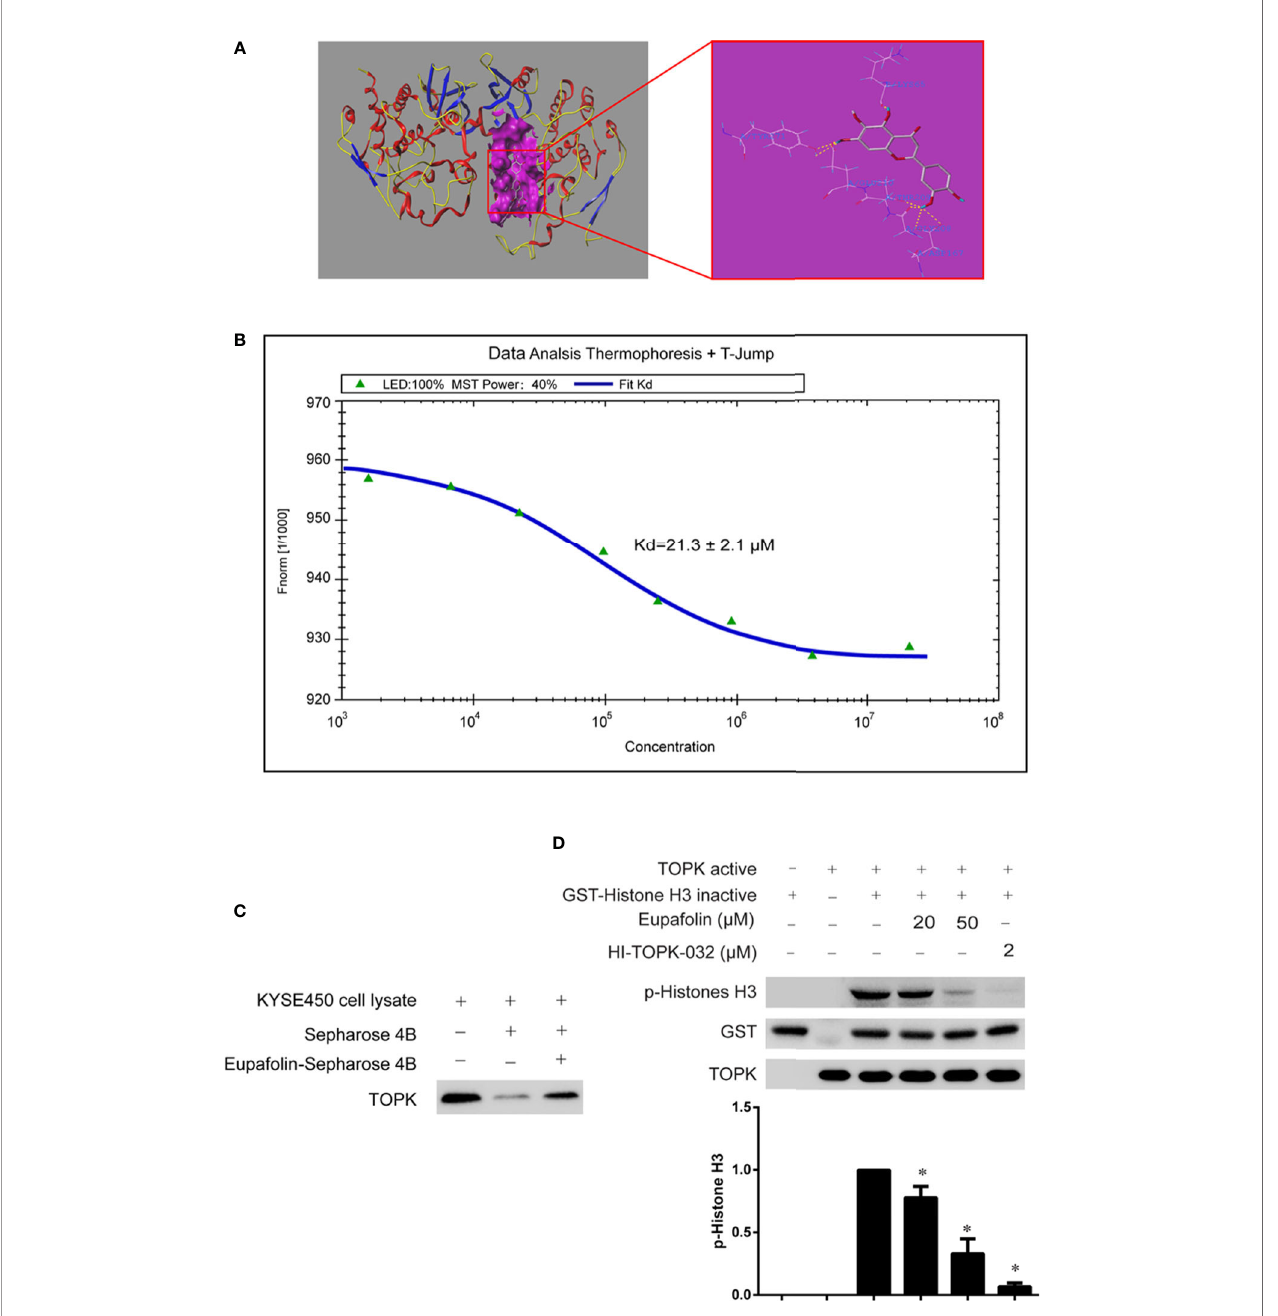
FIGURE 1 | Eupafolin binds with TOPK and suppresses TOPK activity in vitro. (A) The docking model of eupafolin and TOPK. (B) Measurement of af fi nity between TOPK and eupafolin by MST in standard treated capillaries, and the resulting binding curve was shown. From the resulting binding curve, Kd of 21.3 ± 2.1 is calculated. (C) Eupafolin binds directly with TOPK. Sepharose 4B was used for binding and pull-down assay as described in section “ Materials and methods. ” Lane 1 is input control (TOPK protein standard); lane 2 is the negative control, indicating there is no binding between TOPK and beads alone; and, lane 3 indicates that TOPK binds with eupafolin-Sepharose 4B beads. (D) Eupafolin inhibits TOPK activity in vitro. The inhibitory effect of eupafolin on TOPK was determined by an in vitro kinase assay. An inactive GST-histone H3 protein was used as the substrate with active TOPK and 100 m M ATP in the reaction buffer. Protein were resolved by 10% SDS-PAGE gel and detected by Western blot. Histogram statistics is the expression of the p-histone H3 in the fi rst line. Data are representatives of results from triplicate experiments. *Signi fi cant compared with lane 3 alone, P <